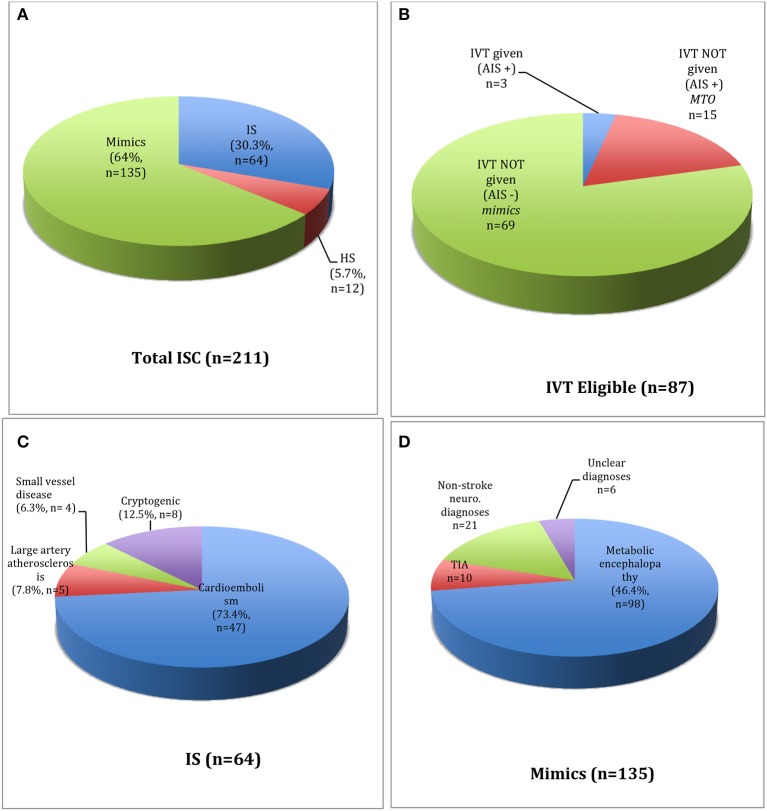
Primary (A) and secondary (B) study cohorts. Breakdown of IS cases (C) and stroke-mimics (D) within the primary study cohort.